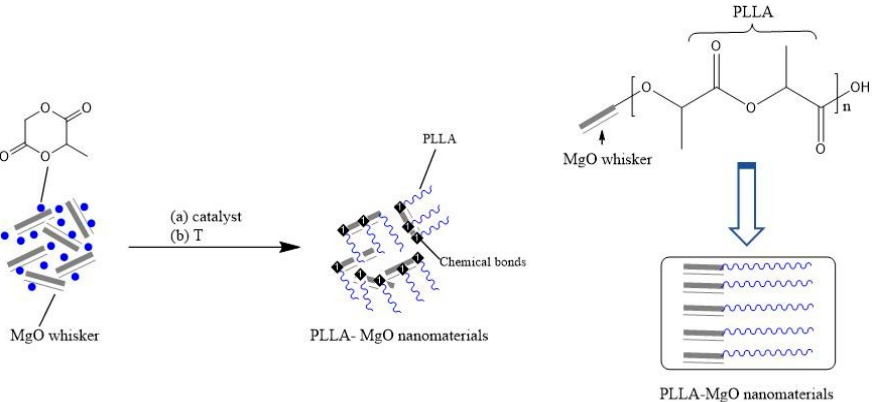
Figure 6. Schematic mechanism of PLLA–MgO via the illustration of chemical bonding between MgO and the PLLA matrix ((a) catalyst, (b) temperature).